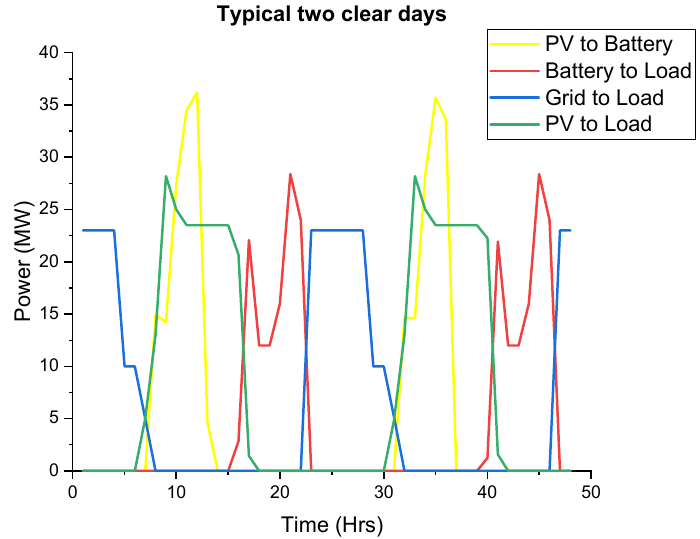
Figure 16. Two typical consecutive days with good PV production. 600